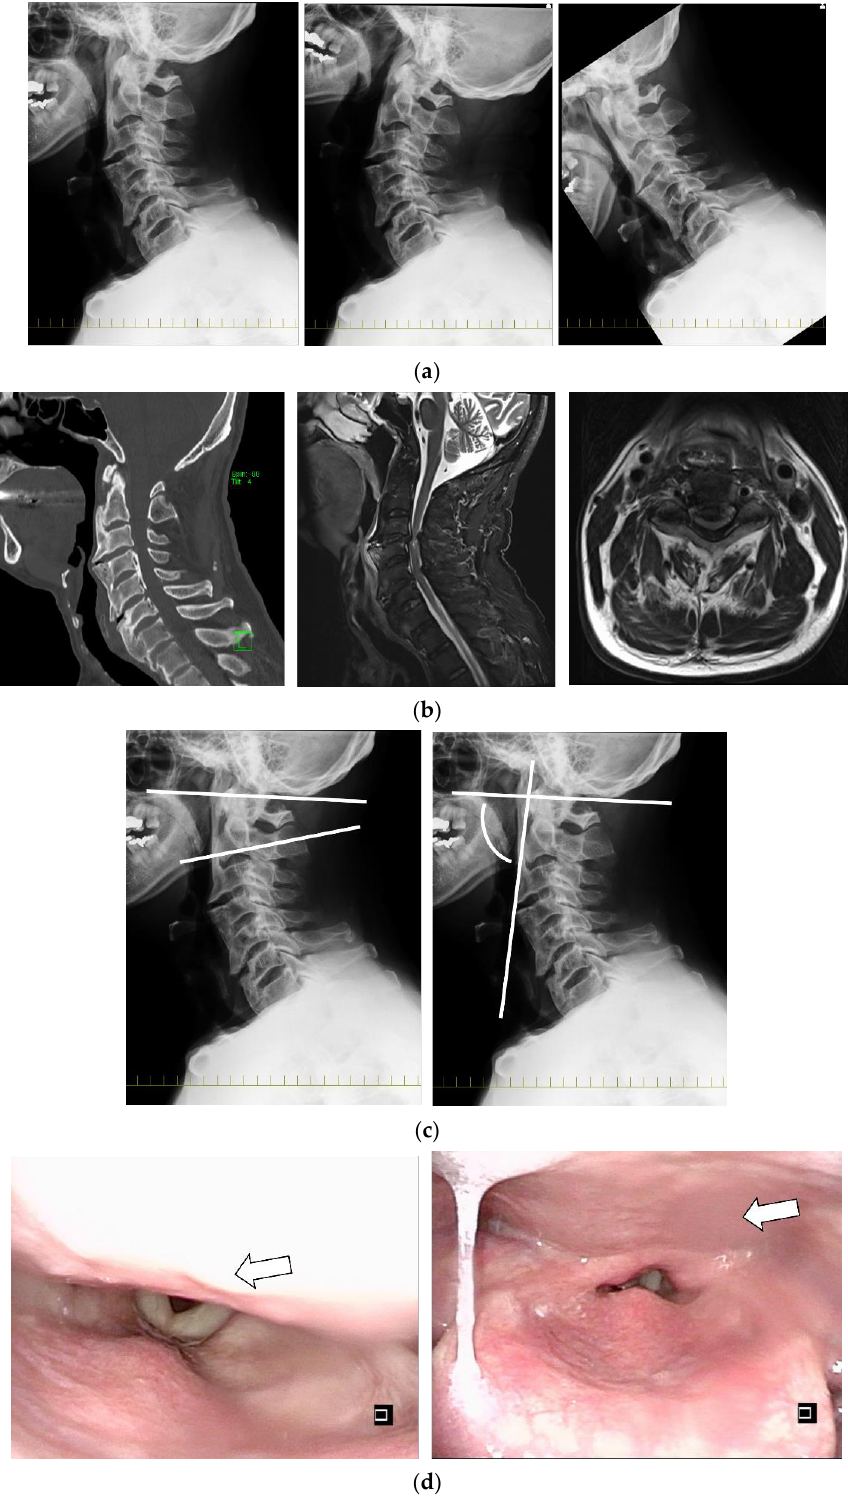
Figure 2. Case 1. ( a ) Functional cervical spine X-ray (figures from left to right show middle, extension, and flexion). ( b ) CT showed no fracture, and MRI showed compression of the cervical spinal cord due to thickening of the ligamentum flavum and suspected damage to the intervertebral disc and anterior longitudinal ligament. MRI showed stenosis at the level of the pharynx due to 16.3 mm OALL at C3/4 and spinal cord compression. ( c ) Figures from left to right show an O-C2 angle of 25 ◦ and a pharyngeal inlet angle (PIA) of 76 ◦ , and the S-line was negative. ( d ) The patient was immobilized in the middle position, and video endoscopy (VE) revealed protrusion of the pharynx due to ossification (arrow), but swallowing was